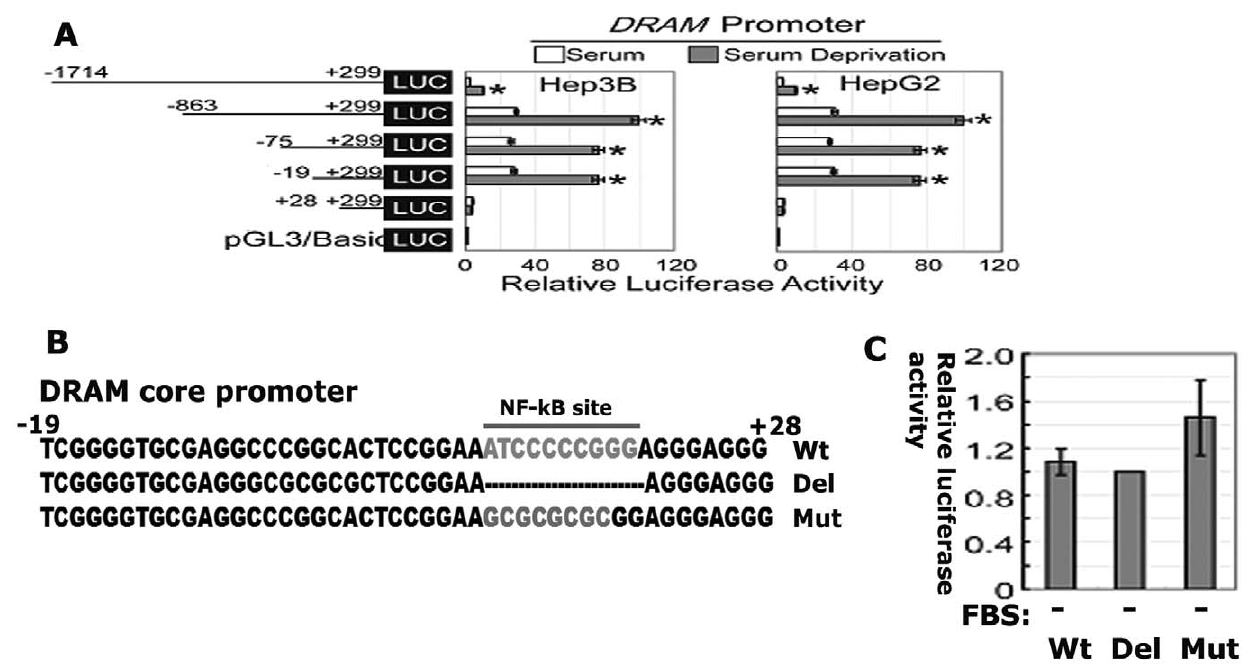
Figure 5. The putative cis regulatory elements responsive to serum deprivation is resided in the DRAM promoter region flanking 2 19/ + 28 nucleotides. (A) Hep3B and HepG2 cells were transiently transfected with reporter plasmids containing truncated versions of the promoter region of the DRAM gene as indicated. Luc-DCP is defined as the reporter containing the shortest promoter region ( 2 19 , + 28). (B) The core promoter region contains a putative NF- k B binding site. Transcription factor binding sites presented in the core promoter region (-19 , + 28) were predicated by web software TFSEARCH and MatInspector and the mutation or deletion plasmids were generated using the site-directed mutagenesis method. (C) Mutation or deletion of the NF- k B binding site does not affect the core promoter activity. Key components of the transcription machinery complex